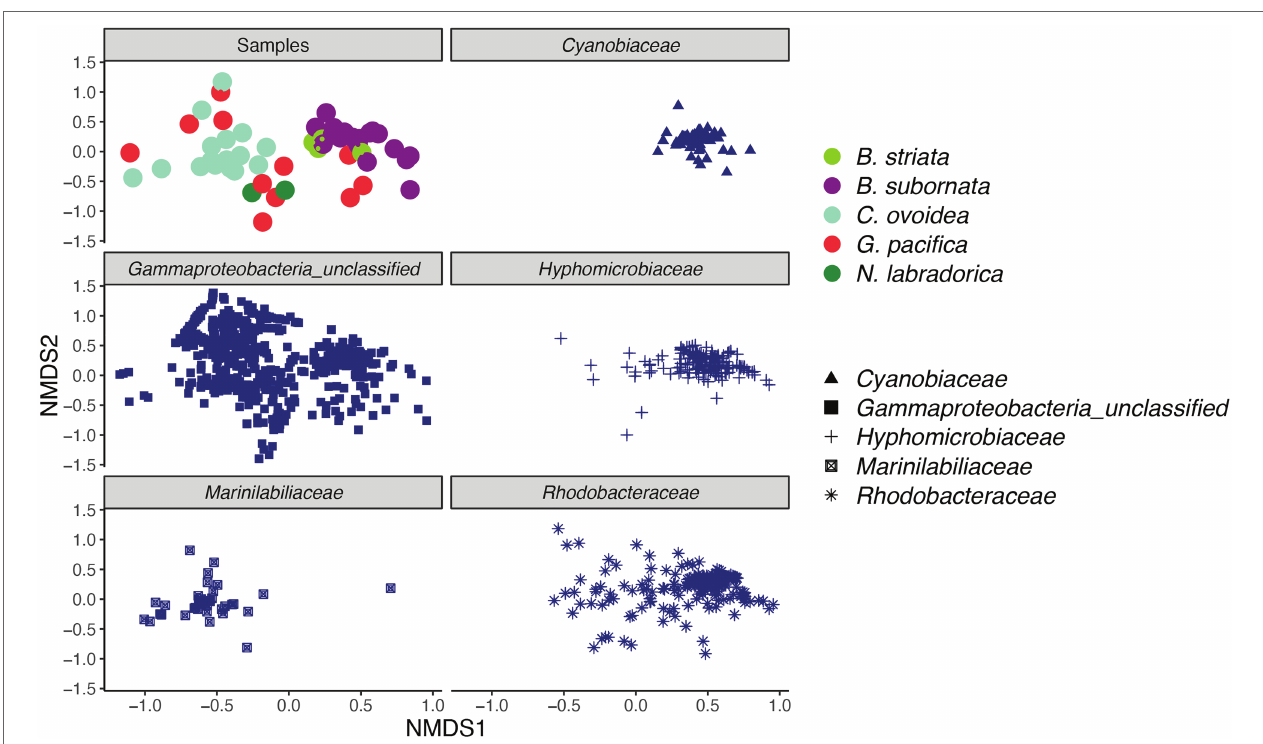
FIGURE 5 | Non-metric multidimensional scaling (nMDS) plot of intracellular bacterial microbiome of foraminiferal species (top left) and five most abundant bacterial families. Foraminiferal species marked in different colors and bacterial families with different shape. nMDS was based on a Bray-Curtis distance (stress 0.198).